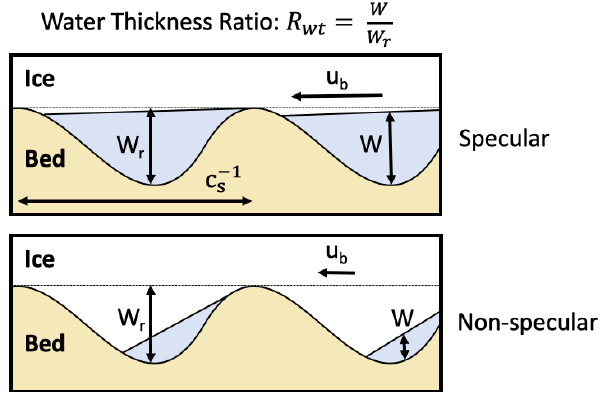
Figure 2. Schematic of a specular and non-specular distributed sys- tem, as defined by the water thickness ratio, R wt . Physical represen- tations of bed roughness parameters are